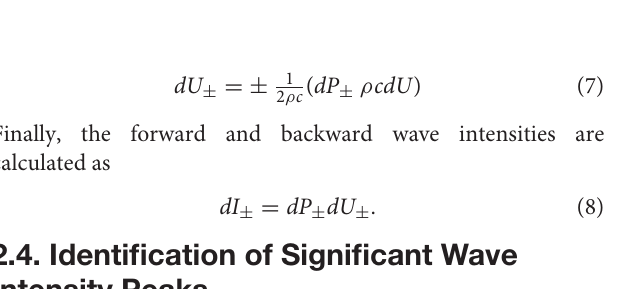
FIGURE 4 | Histogram and total entropy as a function of the thresholds for the log transformed data, (Red) Histogram and total entropy calculated using the ensemble averaged wave intensity signal, (Black) calculated using the total wave intensity